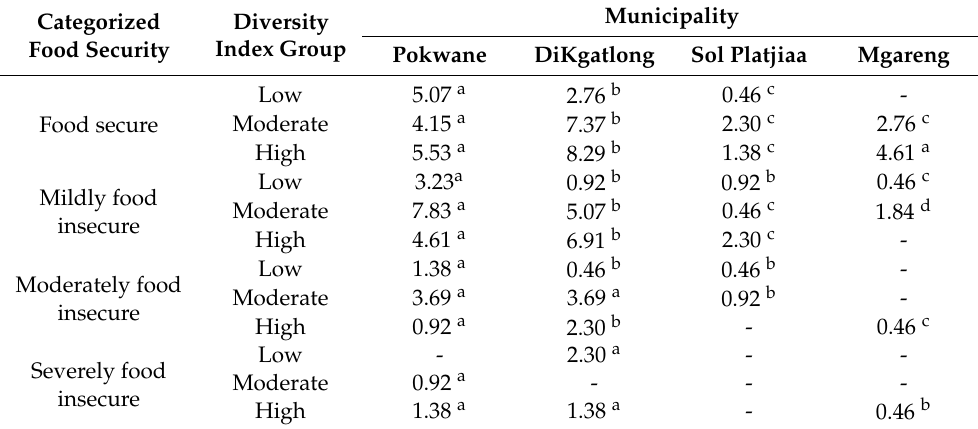
Table 4. Status of HFIAS (%) in the four municipalities according to the diversity